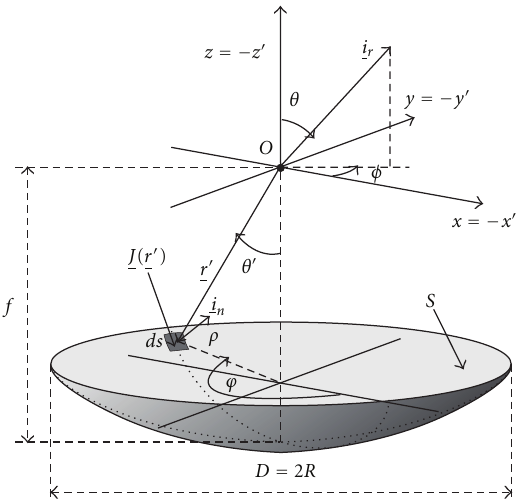
Figure 3: Reflector